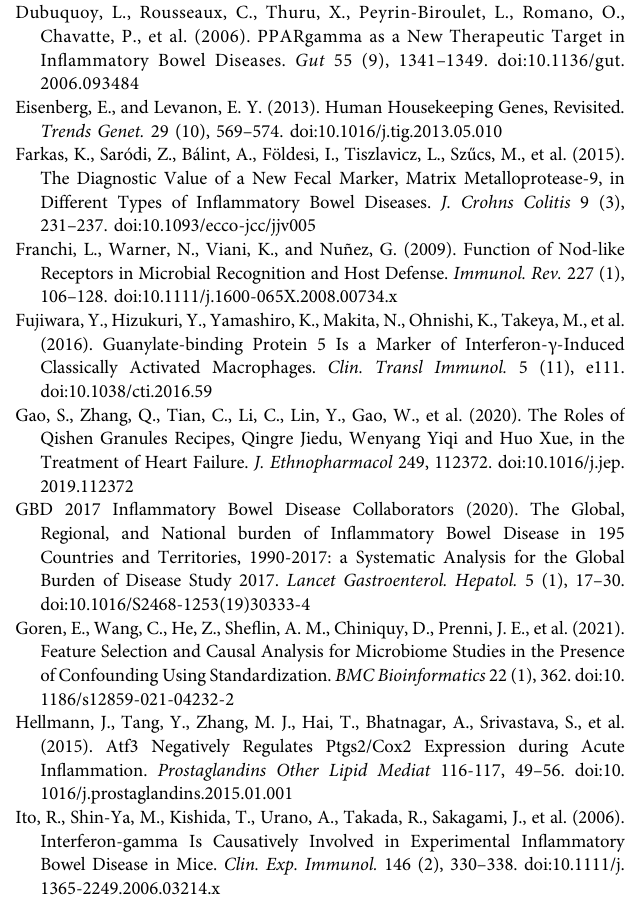
Supplementary Figure S5 | Gene expression of IL1B and IL18 in healthy controls, CD, and UC patients according to transcriptome analysis. The expression of (A) IL1B and (B) IL18 genes in the control, CD, and UC groups. Yellow, CD; orange, UC; gray, control. All data are presented as mean ± standard error. *: p < 0.05; **: p < 0.01; ***: p < 0.001. N = 10, 15, and 13 for CD, UC, and control groups, respectively. (C) Linear regression between NLRP3 and IL1B based on log2-scaled expression values (Spearman; R = 0.7, p = 7.8e-07). (D) Linear regression between NLRP3 and IL18 based on log2-scaled expression values (Spearman; R = 0.4, p = 0.014). Supplementary Figure S6 | Regression analysis of IFNG, GBP5 , and NLRP3 in healthy controls, CD, and UC patients, respectively, according to qRT-PCR data. N = 36, 13, and 33 for CD, UC, and control groups, respectively. (A – C) Linear regression between IFNG and GBP5 based on log2-scaled expression values in CD (Spearman; R = 0.9, p = 1.1e-13), UC (Spearman; R = 0.88, p = 6.6e-05), and control (Spearman; R = 0.63, p = 8.6e-05). (D – F) Linear regression between GBP5 and NLRP3 based on log2-scaled expression values in CD (Spearman; R = 0.78, p = 2e-08), UC (Spearman; R = 0.74, p = 0.0039), and control (Spearman; R = 0.69, p = 7.6e-06). (G – J) Linear regression between IFNG and NLRP3 based on log2-scaled expression values in CD (Spearman; R = 0.61, p =7.2e-05), UC (Spearman; R = 0.67, p = 0.013), and control (Spearman; R = 0.48, p =